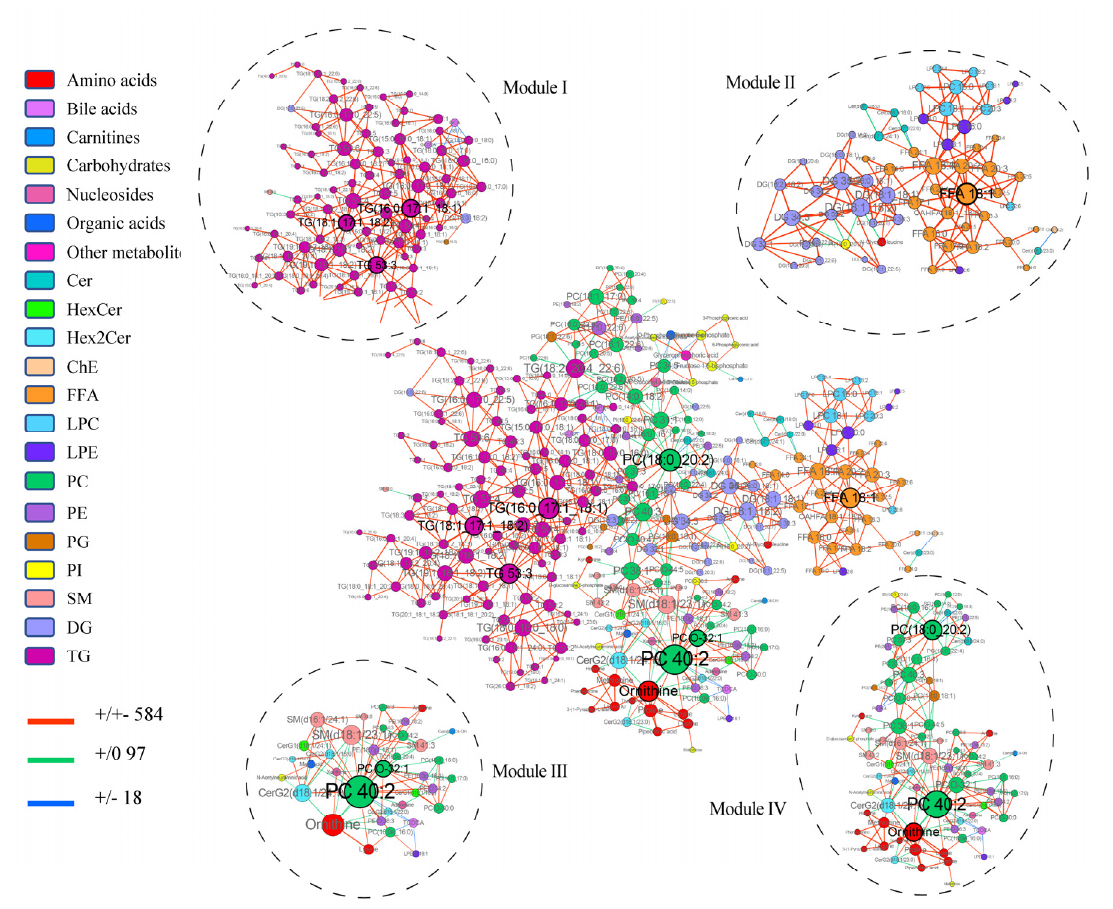
Figure 4. Differential correlation analyses of tissue metabolites and lipids in HCT relative to ANT. Only molecule pairs with significant differential correlations ( p < 0.05) are included. Sign/sign indicates the direction and strength of the correlation in HCT/ANT, and the number that follows indicates the number of molecule pairs in the global networks exhibiting this pattern of change. For instance, the red line +/+ − 584 indicates that correlation between two connected molecule pairs was positive (+) in ANT, and the correlation became weaker positive (+ − ) in HCT. A total of 584 molecule pairs connected by red lines in the global network displayed this pattern of change (+/+ − ). The hub nodes are labeled with black font.